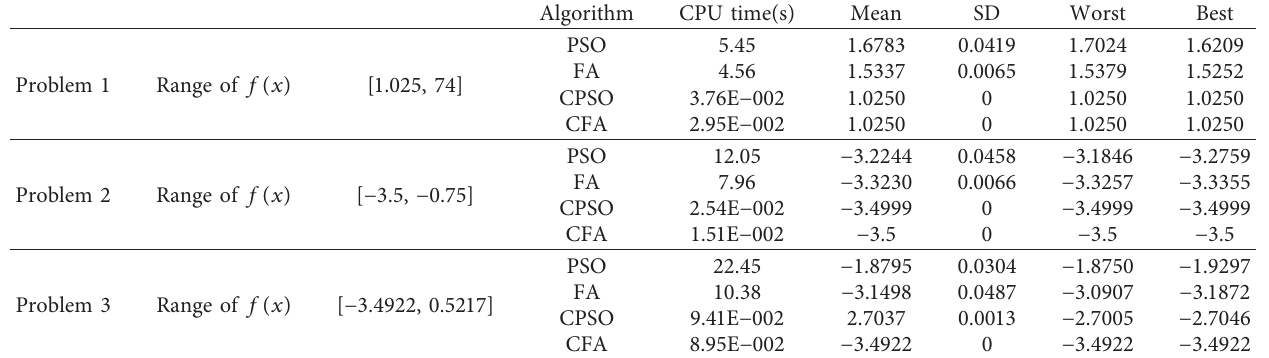
Table 5: The statistical results of SAs over the 30